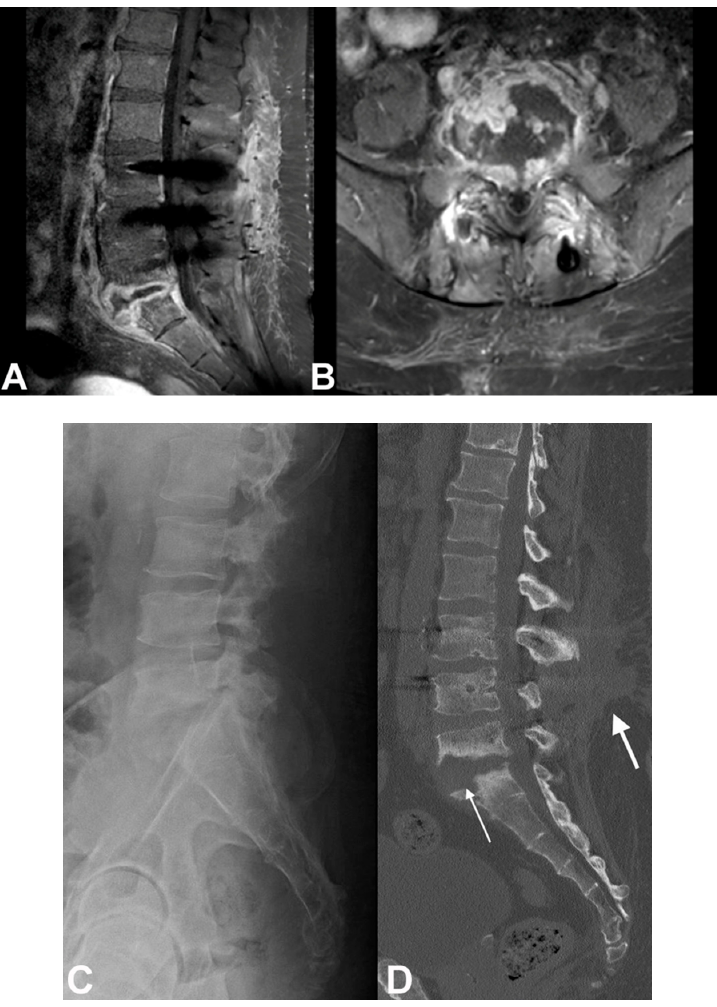
Figure 3. A 42-year-old woman with insulin dependent diabetes mellitus and obesity, and MRSA infection 1 year after L3-L5 laminectomy and spinal instrumentation. ( A ) Sagittal and ( B ) axial MR